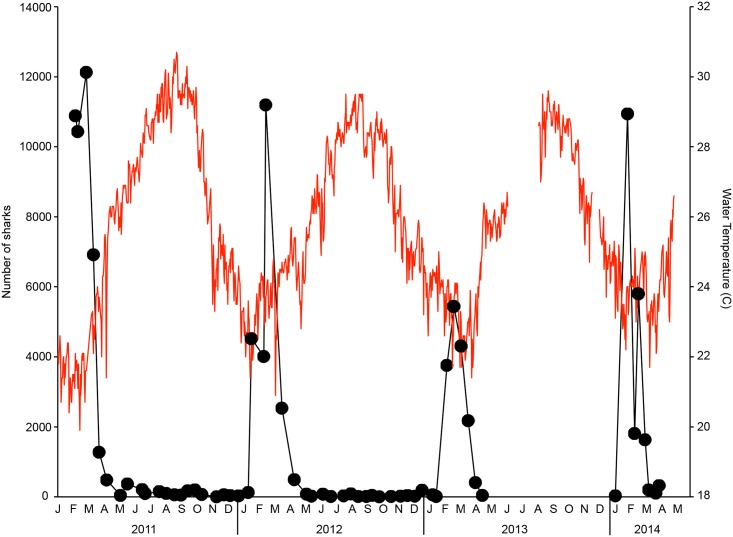
Seasonal shark abundance and water temperature.The number of sharks (black circles) correlates inversely with water temperature (red lines). Shark abundance peaks from January-March which corresponds with the lowest water temperatures.